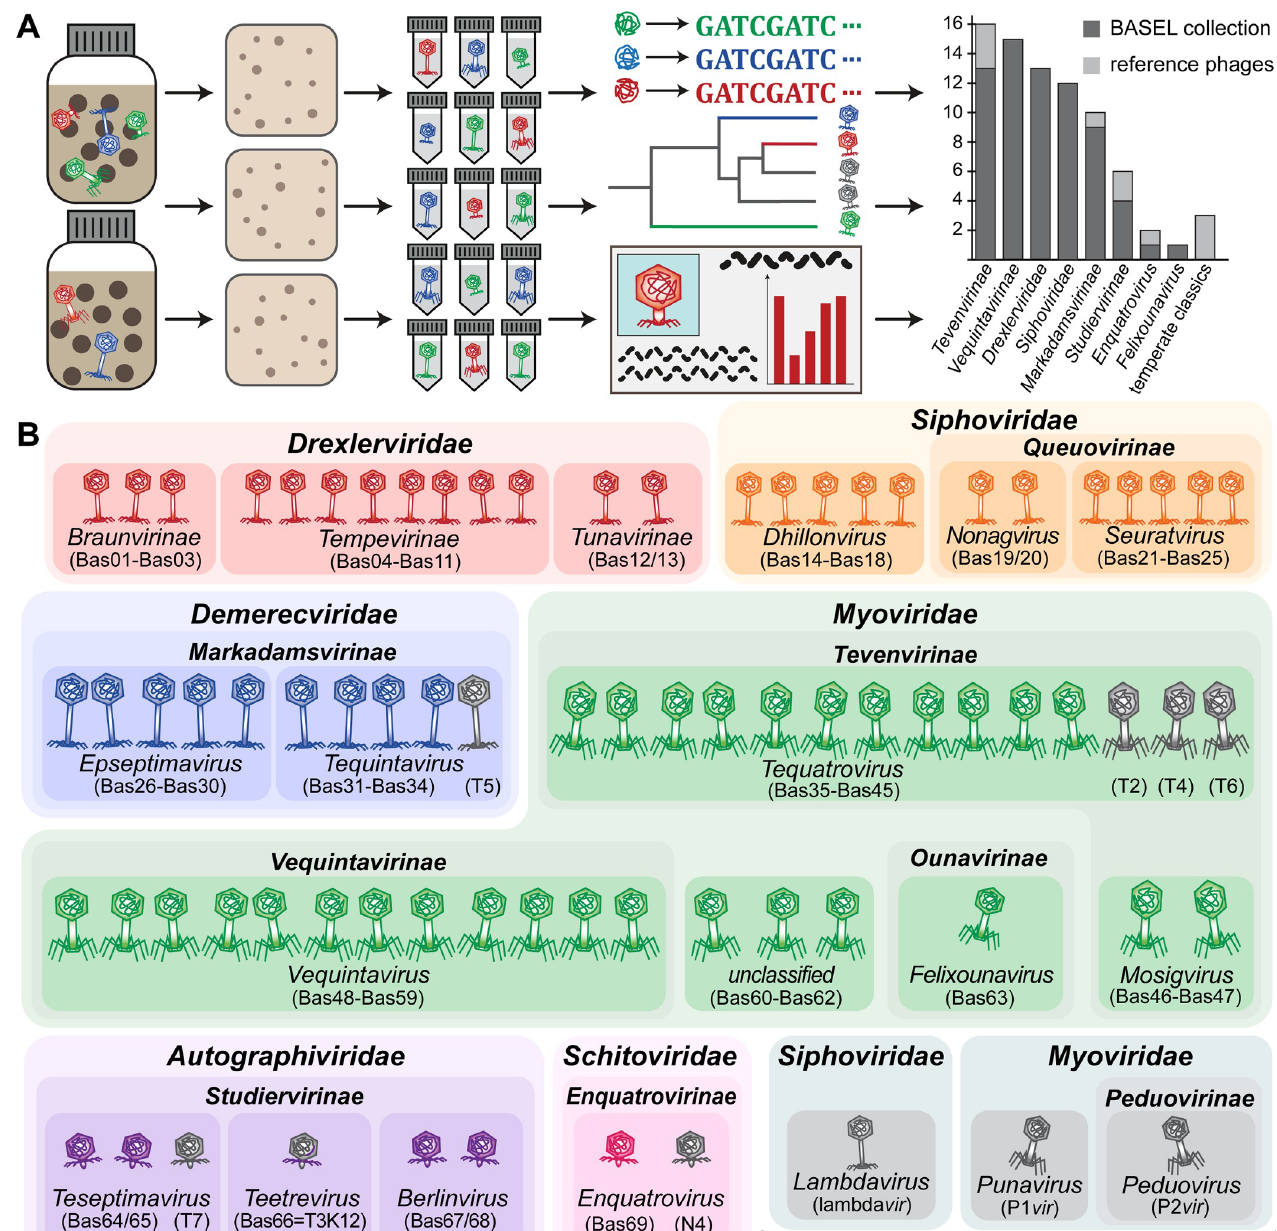
Fig 1. Overview of the BASEL collection. (A) Illustration of the workflow of bacteriophage isolation, characterization, and selection that resulted in the BASEL collection (details in Materials and methods; the bar diagram includes phi92-like phages in Vequintavirinae for simplicity). (B) Taxonomic overview of the bacteriophages included in the BASEL collection and their unique Bas## identifiers. Newly isolated phages are colored by current taxonomic classification, while reference phages are shown in gray. BASEL, BActeriophage SElection for your Laboratory.